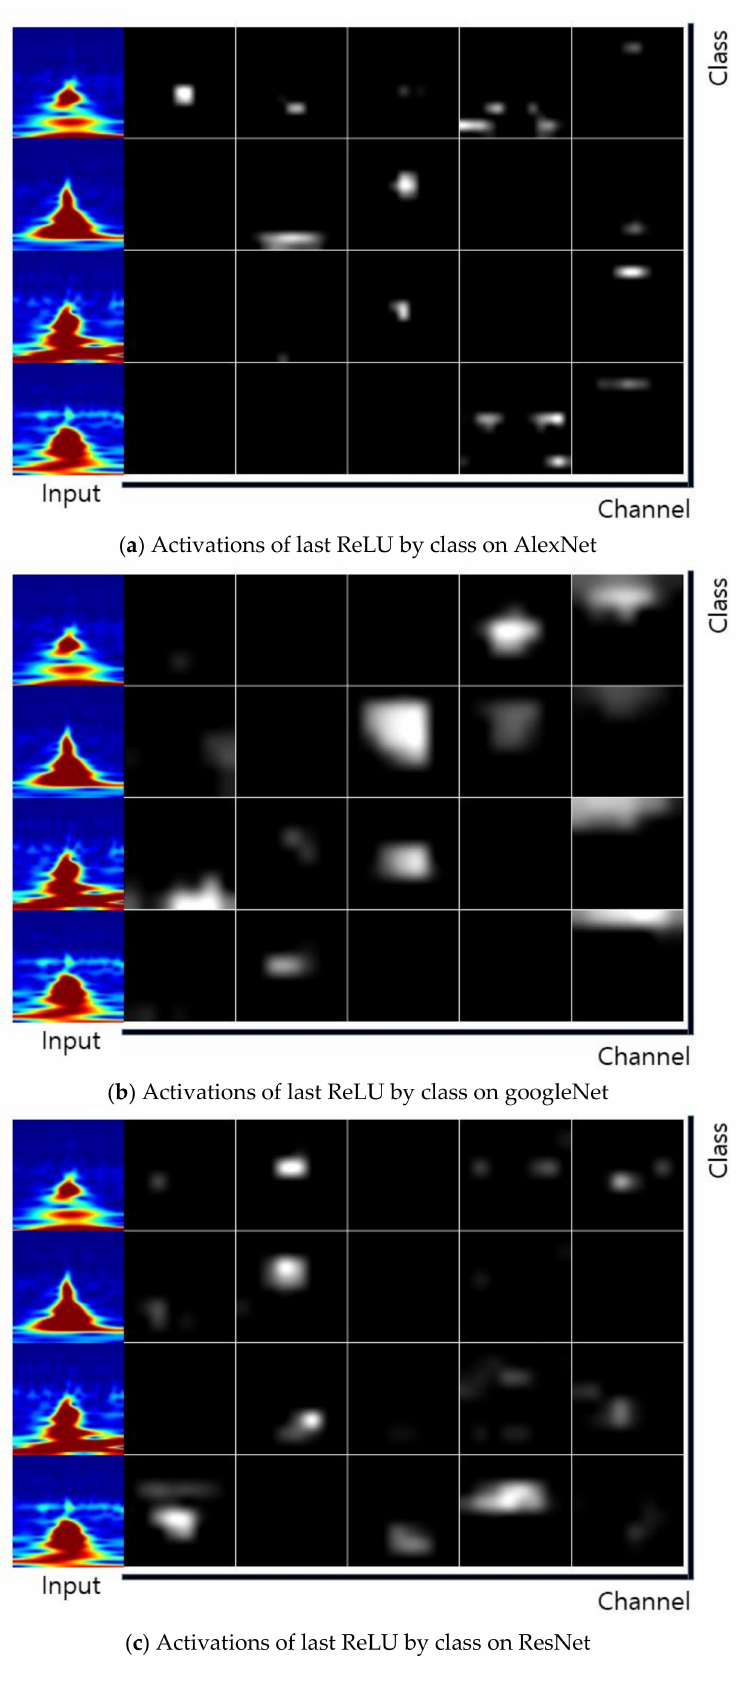
Figure 16. Comparison of the activations of the last ReLU by class in